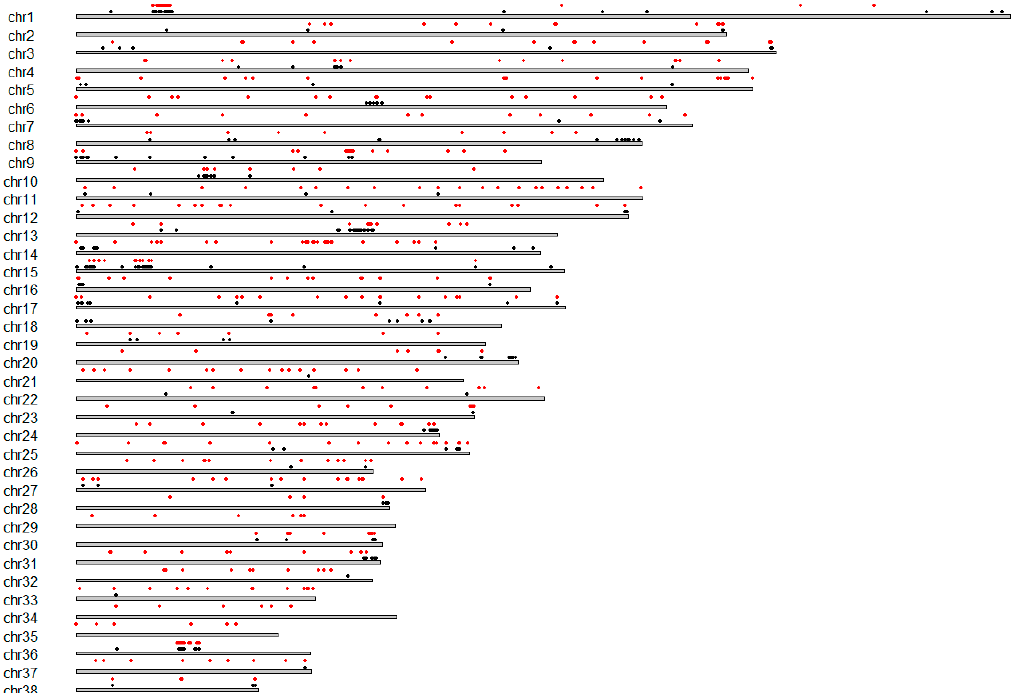
Figure 2. Genomic distribution of copy number variations (CNVs) in Braque Français, type Pyrénées breed. The points in black showed the CNVs identified with PennCNV, whereas in red are reported the CNV identified with Copy Number Analysis Module-SVS.